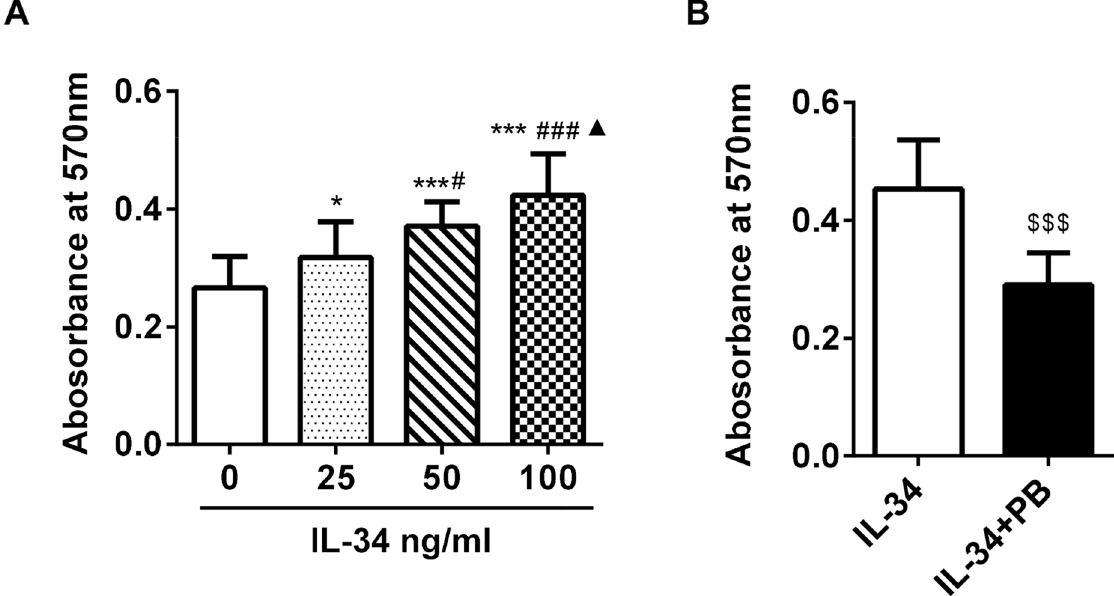
Figure 1. IL-34 promoted the proliferation of RA-FLSs by regulating IL-17. ( A ) The MTT assay was used to measure RA-FLS proliferation. RA-FLSs were treated with different concentrations of IL-34 (0 ng/ml, 25 ng/ml, 50 ng/ml and 100 ng/ml). ( B ) RA-FLSs were treated with IL-34 (100 ng/ml) or IL-34 (100 ng/ml) + PB (4 µM). The differences between the four groups were tested by ANOVA. Statistical comparisons between two groups were performed by t-tests. The data are expressed as the mean ± SEM. * P < 0.05, *** P < 0.001 vs the 0 group; # P < 0.05, ### P < 0.001 vs the 25 group; ▲ P < 0.05 vs the 50 group; $$$ P < 0.001 vs the IL-34